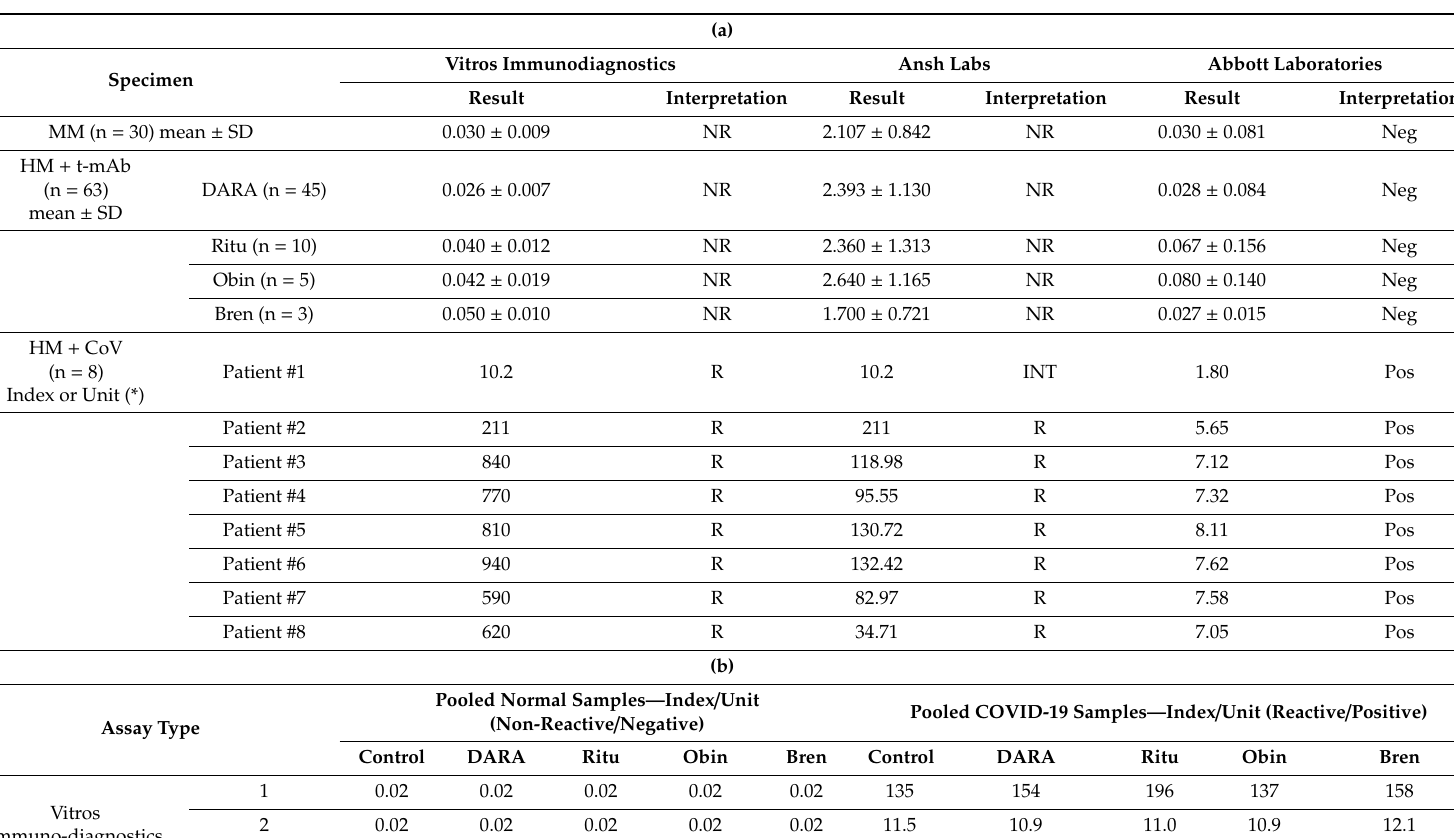
Table 1. ( a ) SARS CoV-2 serology assay test results of hematological malignancy patients treated with and without anti-myeloma monoclonal antibodies or having suspected COVID-19 infection. ( b ) SARS CoV-2 serology test results of normal and COVID-19 positive pooled samples spiked with therapeutic anti-monoclonal antibodies in